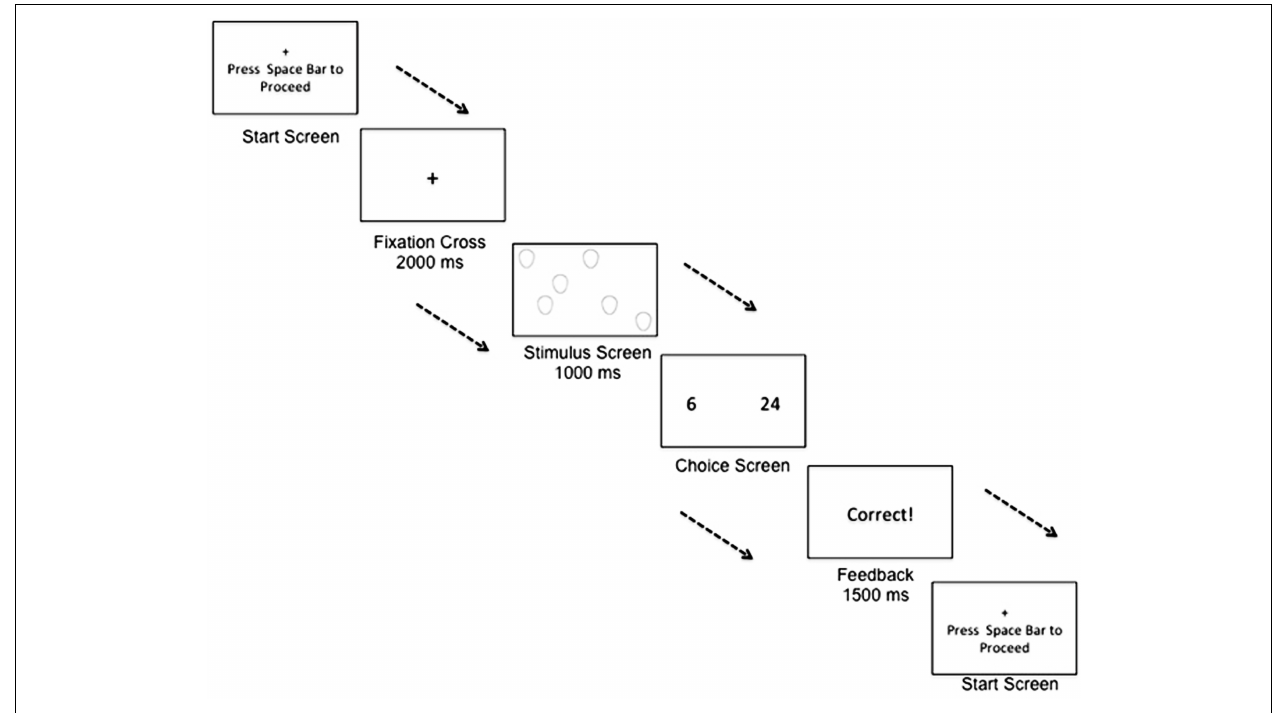
enumerate.The participant is then shown a choice screen, and must decide whether the stimulus numerosity was closer in numerical quantity to the small anchor quantity or the large anchor quantity.